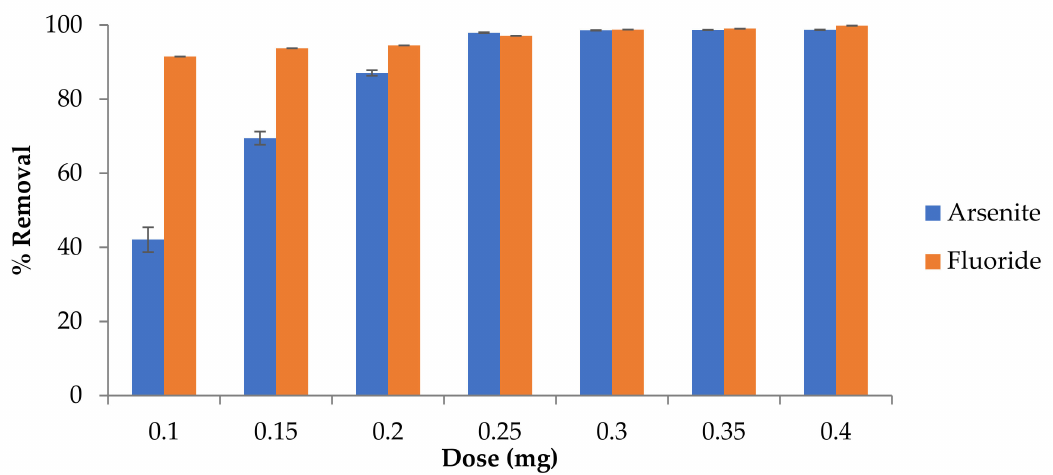
Figure 8. Effect of adsorbent dose on As 3+ and F − sorption. Initial F − and As 3+ concentrations: 5 and 10 mg/L; adsorbent solution volume: 50 mL; contact time: 40 min; shaking speed: 250 rpm at 297